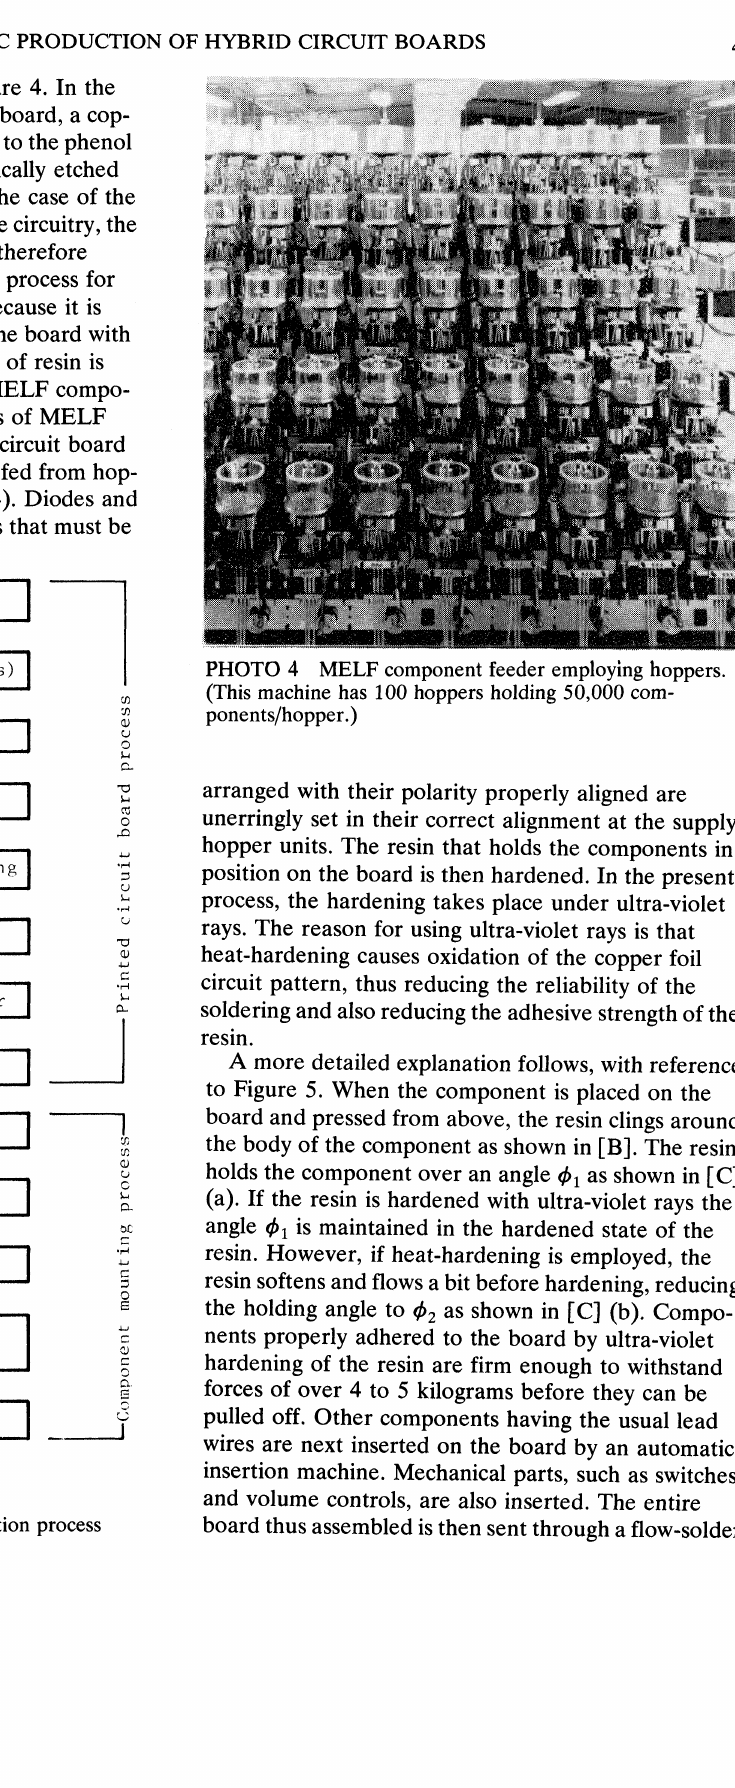
FIGURE 4 Diagram of UHIC production